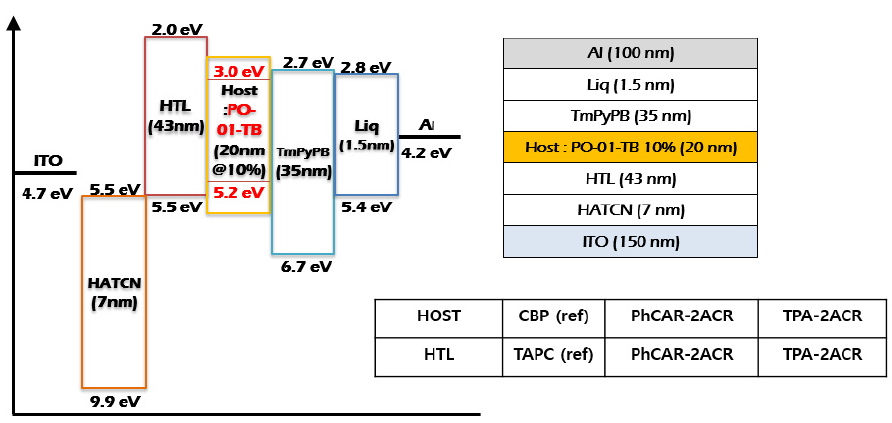
Figure 5. Device energy diagram and device structure of phosphorescent OLEDs.